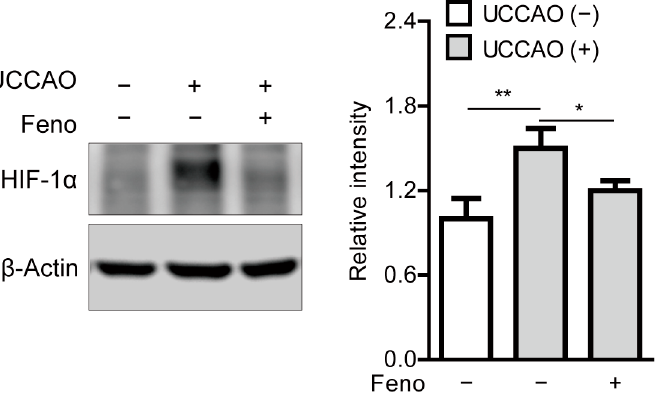
Figure 6. Reduction in stabilization of retinal hypoxia-inducible factor-1 α (HIF-1 α ) by oral administration of fenofibrate in the UCCAO-operated mice. A representative image and quantitative analysis ( n = 4–5 per group) show that oral administration of fenofibrate significantly suppressed HIF-1 α stabilization in the retina 8 h after UCCAO. * p < 0.05, ** p < 0.01. The data were analyzed using one-way ANOVA followed by a Bonferroni post hoc test and presented as mean ± standard deviation. Feno; fenofibrate. UCCAO; unilateral common carotid artery occlusion.